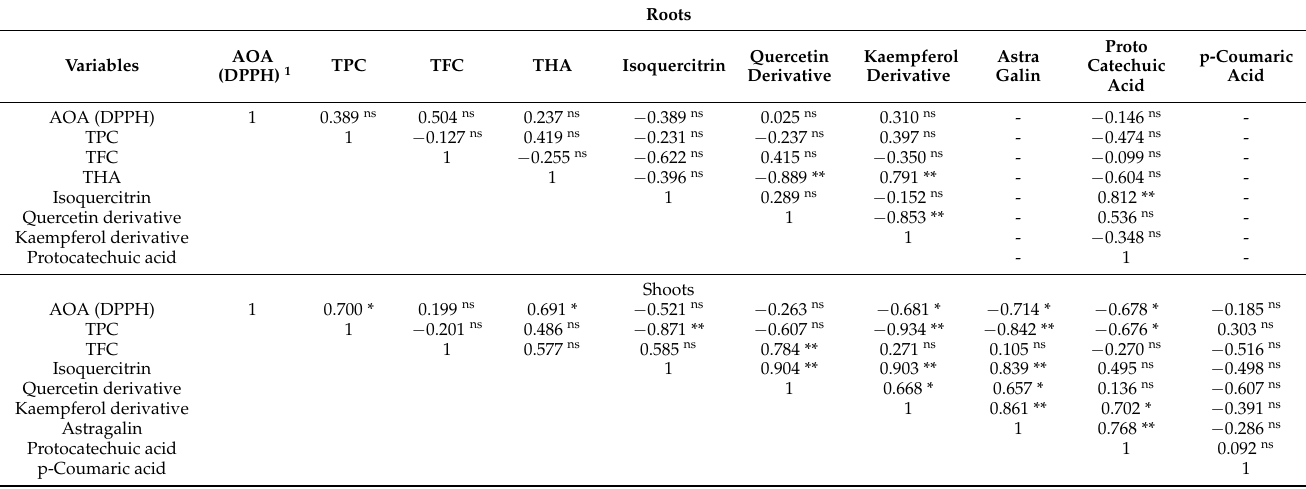
Table 4. Correlation matrix with the Pearson coefficient values for phenolic compounds and antioxi- dant activity of G. maritima .